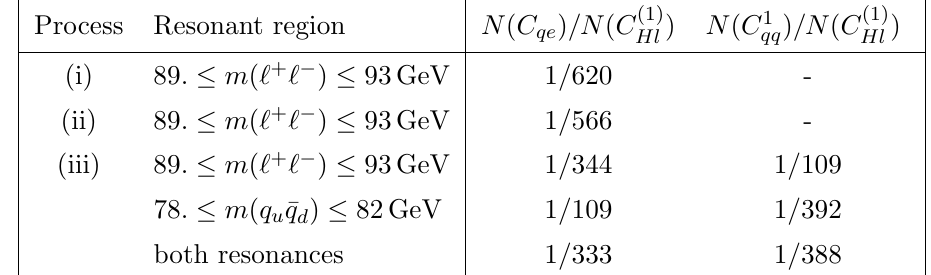
Table 9 . Approximate ratios of the number of events contained in the central peak regions of the rel- evant invariant mass spectra determined by the pure SM{ vs pole ( C (1) ) parameters in the three processes considered. The values can be compared with the Hl order of magnitude estimate of eq. (10.5), that gives (cid:0) B m B = (cid:22) g 2 (cid:22) v 2